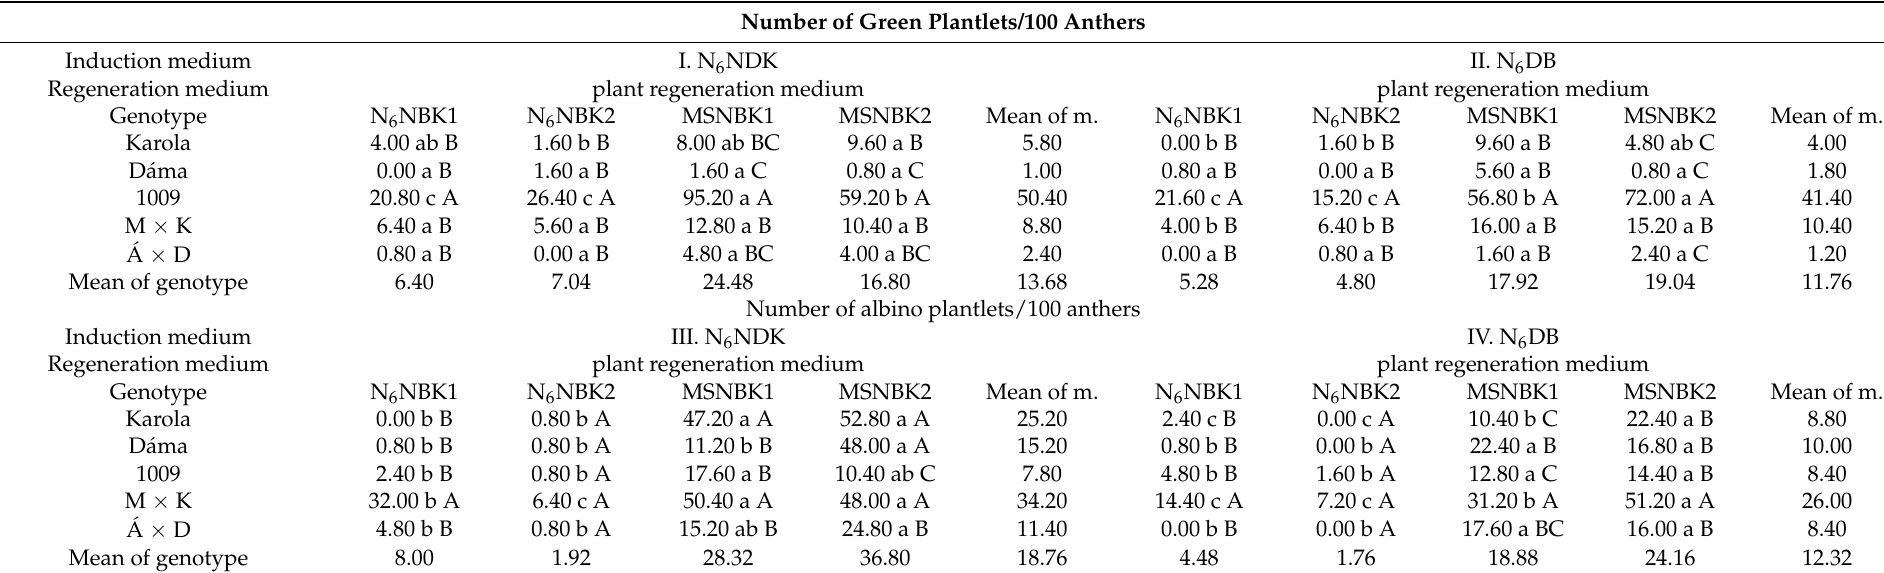
Table 4. Comparison of different plant regeneration media (1, N 6 NBK1; 2, N 6 NBK2; 3, MSNBK1 4; MSNBK2) based on plant regeneration efficiency (number of green and albino plantlets/100 anthers) of AC-culture-derived calli induced on N 6 NDK and N 6 DB induction media. Values followed by corresponding lower-case letters (a, b etc.) are not significantly different ( p < 0.005) within the same genotype (I, II, III and IV). Values followed by corresponding capital letters (A, B etc.) are not significantly different ( p < 0.005) within the same